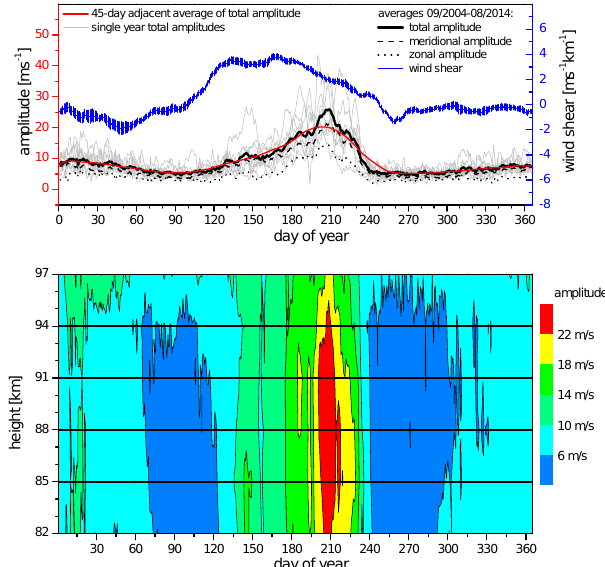
Figure 2. Upper panel: total annual amplitudes between Septem- ber 2004 and August 2014 (light gray). Average values of the years 2004–2014 in black for total (straight), meridional (dashed) and zonal (dotted) components. The 45-day adjacent average for the to- tal annual amplitude is in red. The blue curve denotes the vertical shear of zonal wind including standard error. Data refer to an alti- tude of 91km. Lower panel: contour plot of the 10-year mean am- plitudes over height in an annual cycle. The horizontal lines (black) mark the six height gates. Data are interpolated in